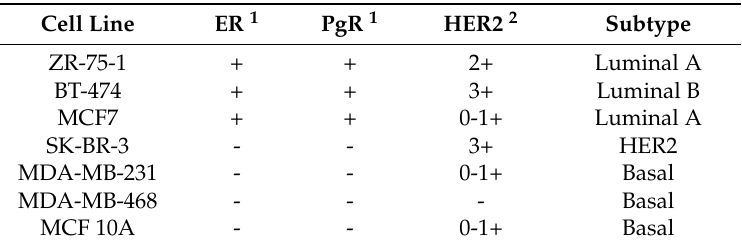
Table 1. Classification of breast cancer cell lines [16,27].